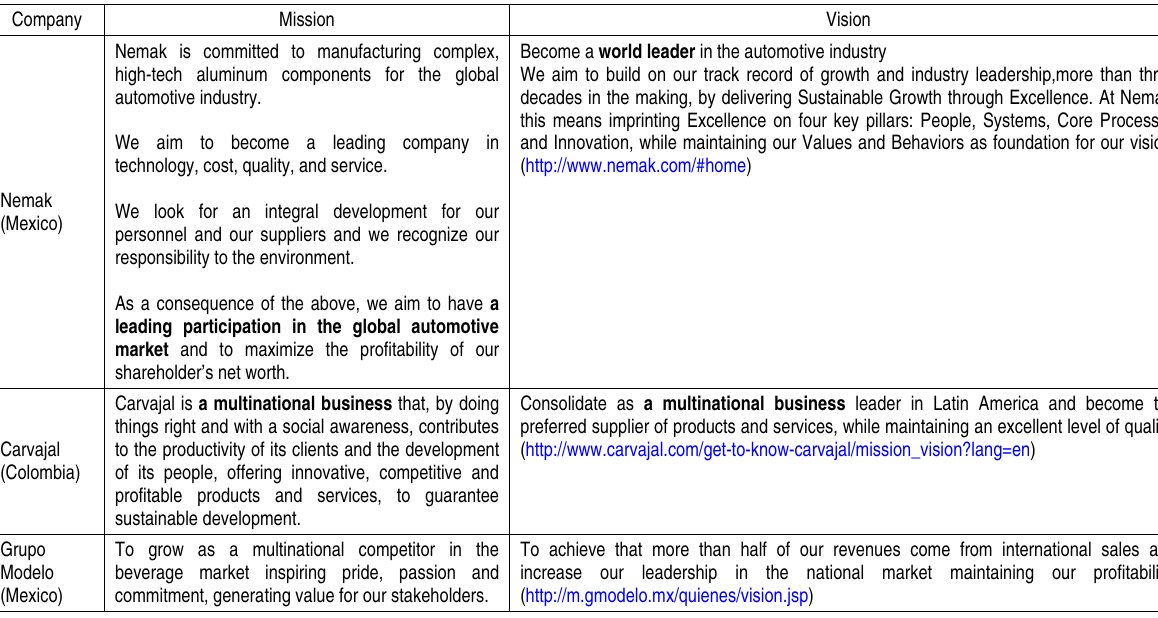
Table 3 (cont.). Examples of the presence of IS in the mission and vision of the companies Company Mission Vision Nemak is committed to manufacturing complex, high-tech aluminum components for the global automotive industry.